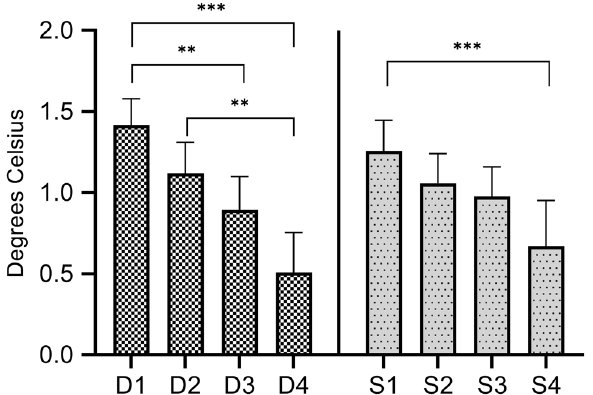
Figure 3. Comparisons of temperature differences between the median and ulnar nerve territories (ΔM-U territories) according to the symptom duration and disease severity groups. Significant differences in ΔM-U territories between the D1 and D3, D1 and D4, D2 and D4, and S1 and S4 groups are observed. This graph is drawn using GraphPad Prism version 9.1.2 for Windows (GraphPad Software, San Diego, California USA, www.